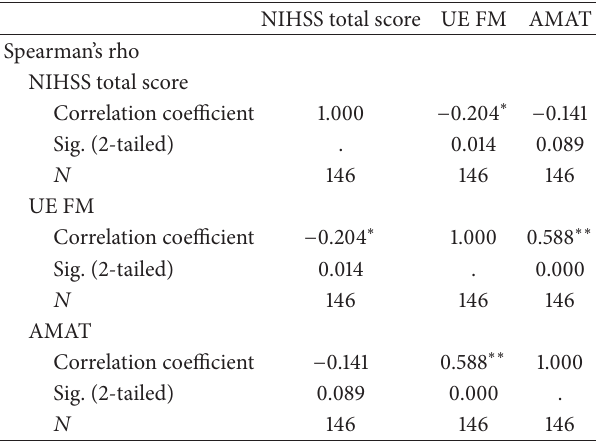
Table 1: Correlation matrix of NIHSS, UE FM, and AMAT